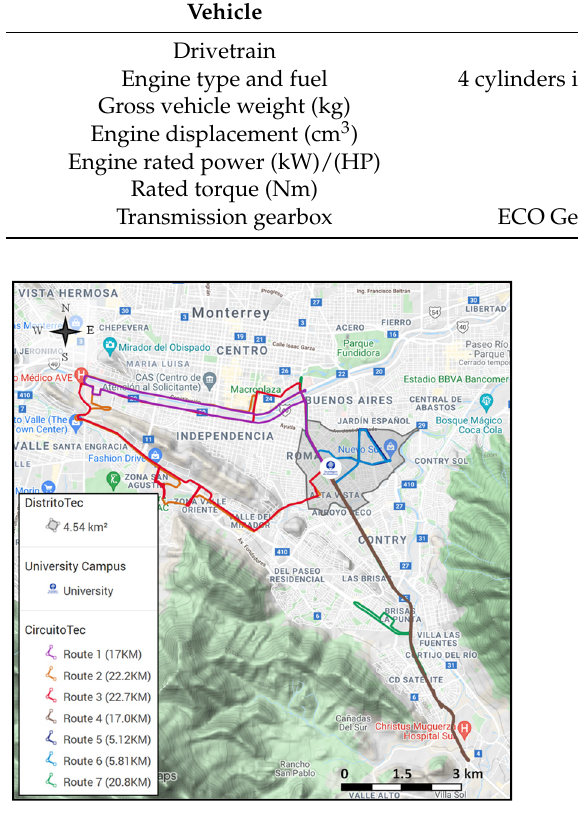
Figure 2. CircuitoTec shuttle service routes. Table 1. Shuttle service vehicle specifications.